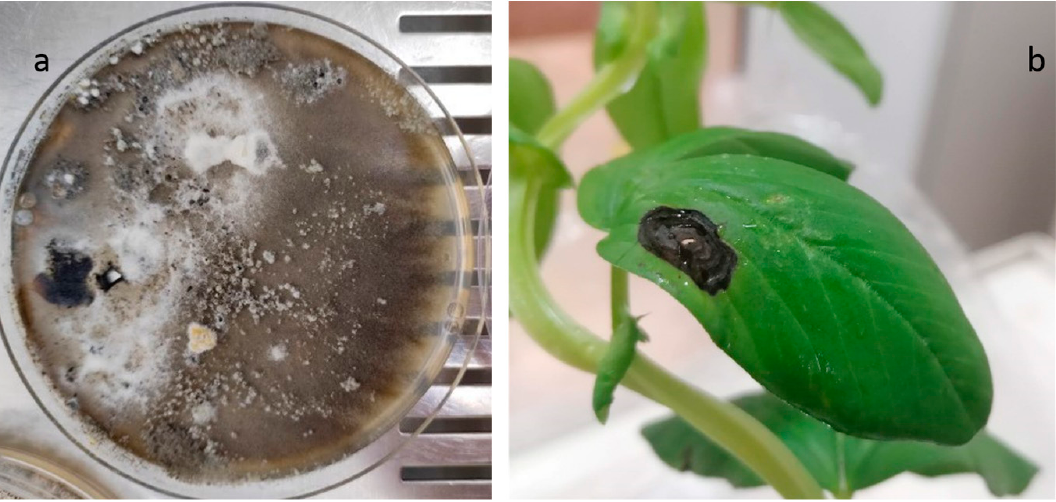
Figure 8 . S. vesicarium CREA OF 1112.1 symptoms on inoculated broad bean “A sciabola” local va- Figure 8. S. vesicarium CREA OF 1112.1 symptoms on inoculated broad bean “A sciabola” riety: ( a ) colony morphology of CREA OF 1112.1 on PDA; ( b ) necrotic spots on broad bean leaves.